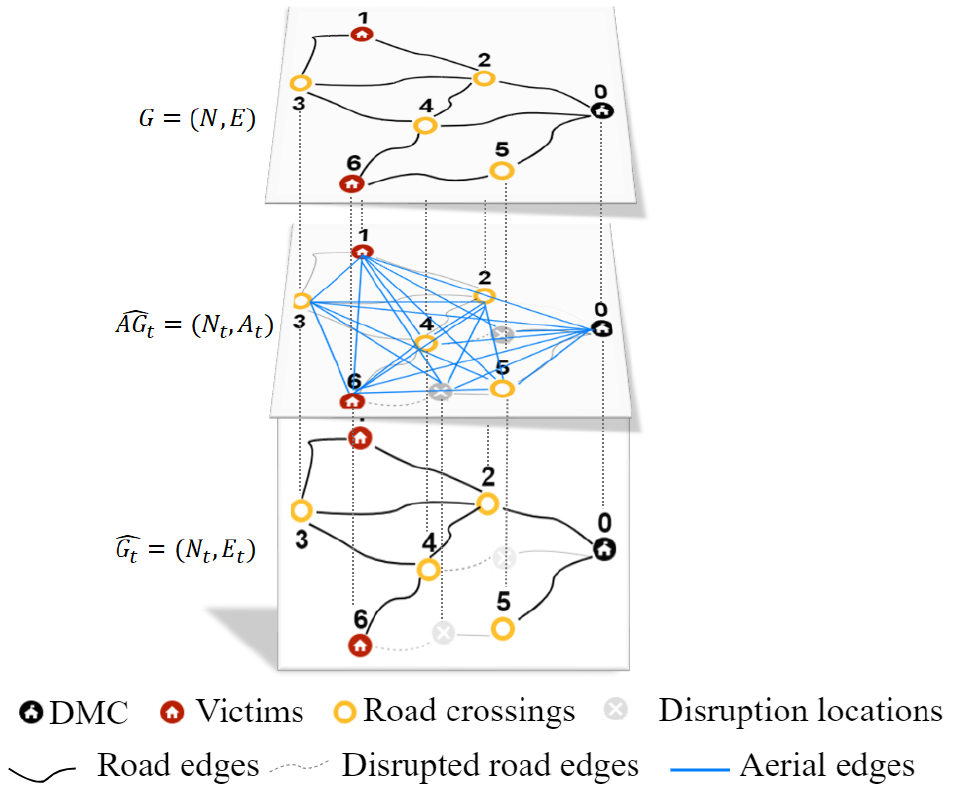
Figure 4. Example of the relationship between networks involved in the on-line UAV routing